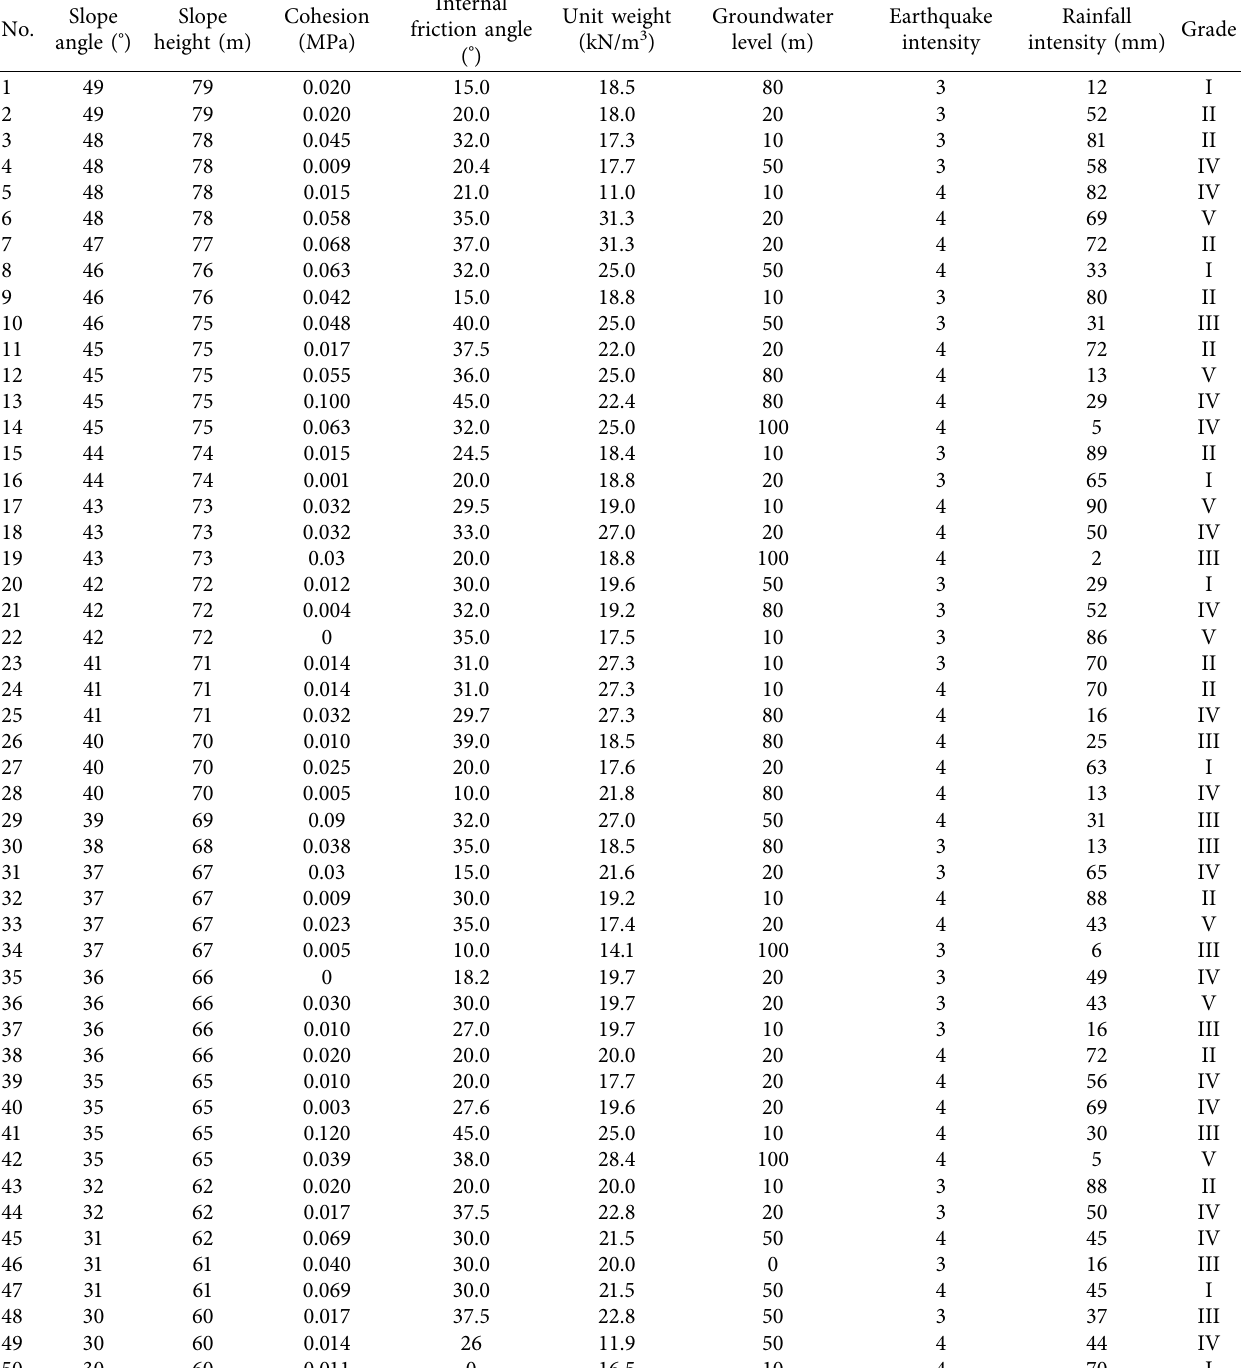
Table 3: Training samples of the slope